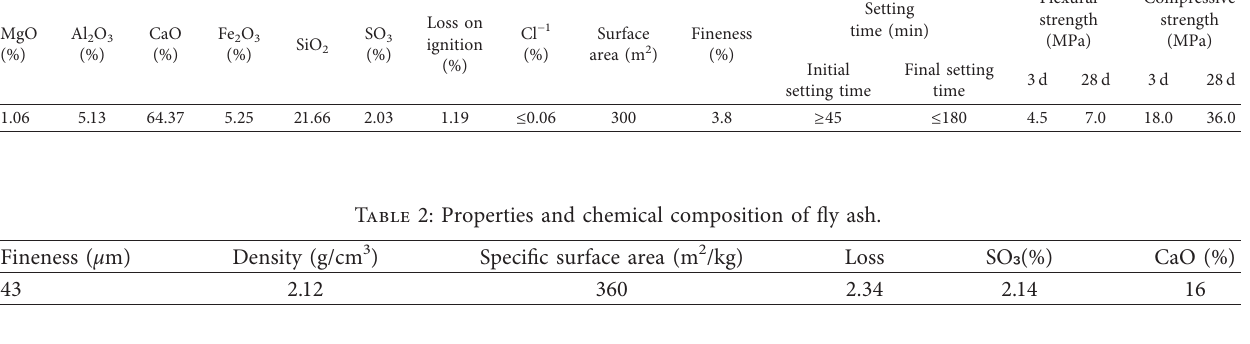
Table 3: Mix proportions in kg/m 3 (except w/c) of concretes investigated in this study.